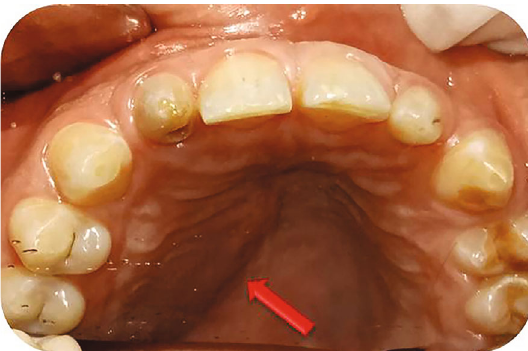
Figure 1: Preoperative photograph showing a palatal swelling on the right side.